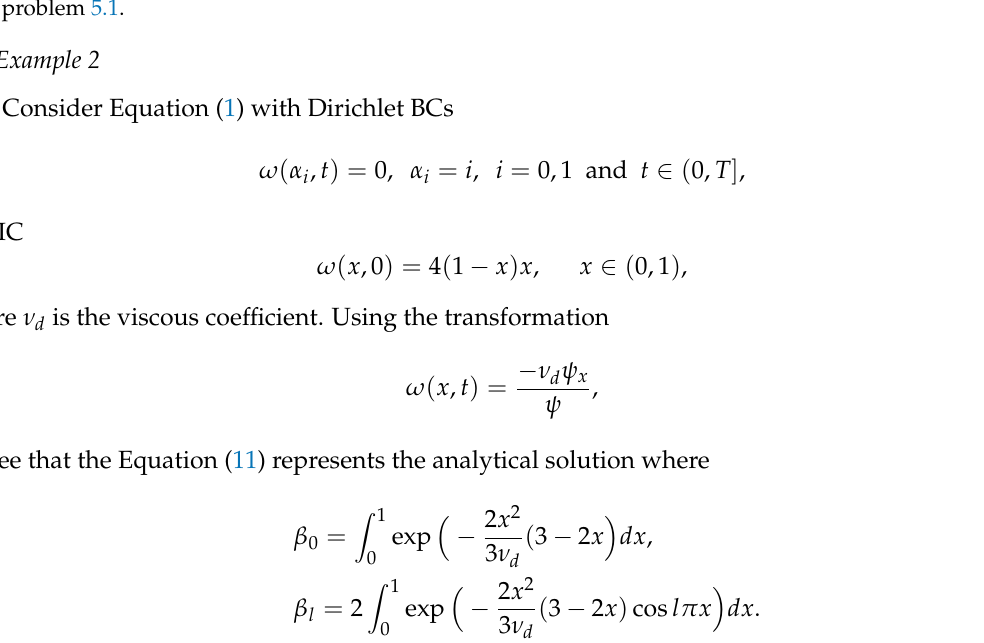
Figure 6. Numerical results with ν d = 0.01, ∆ x = 0.0125 and τ = 0.001 at different times T of problem